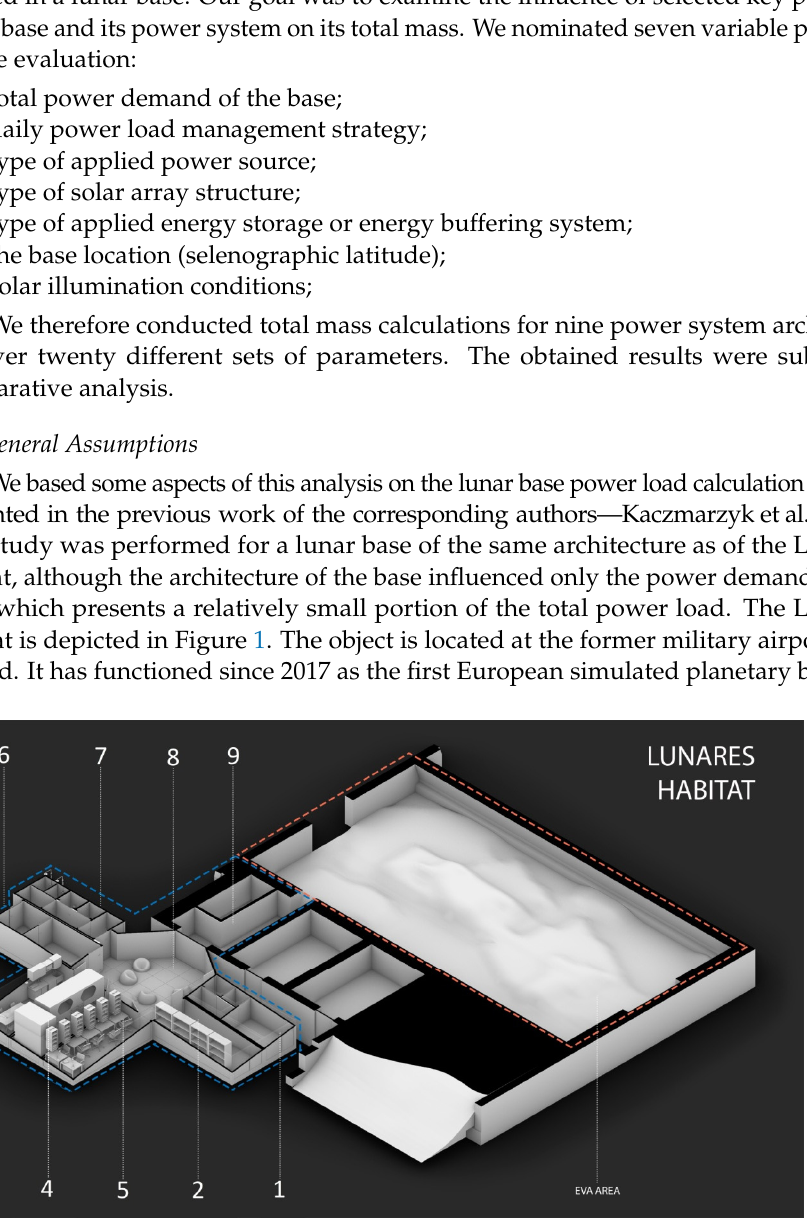
Figure 1. An axonometric projection of the LUNARES habitat three-dimensional model. Source: Leszek Orzechowski and Agata Mintus. Layout of LUNARES habitat is presented in Table 3. Table 3. Compartments in LUNARES habitat.